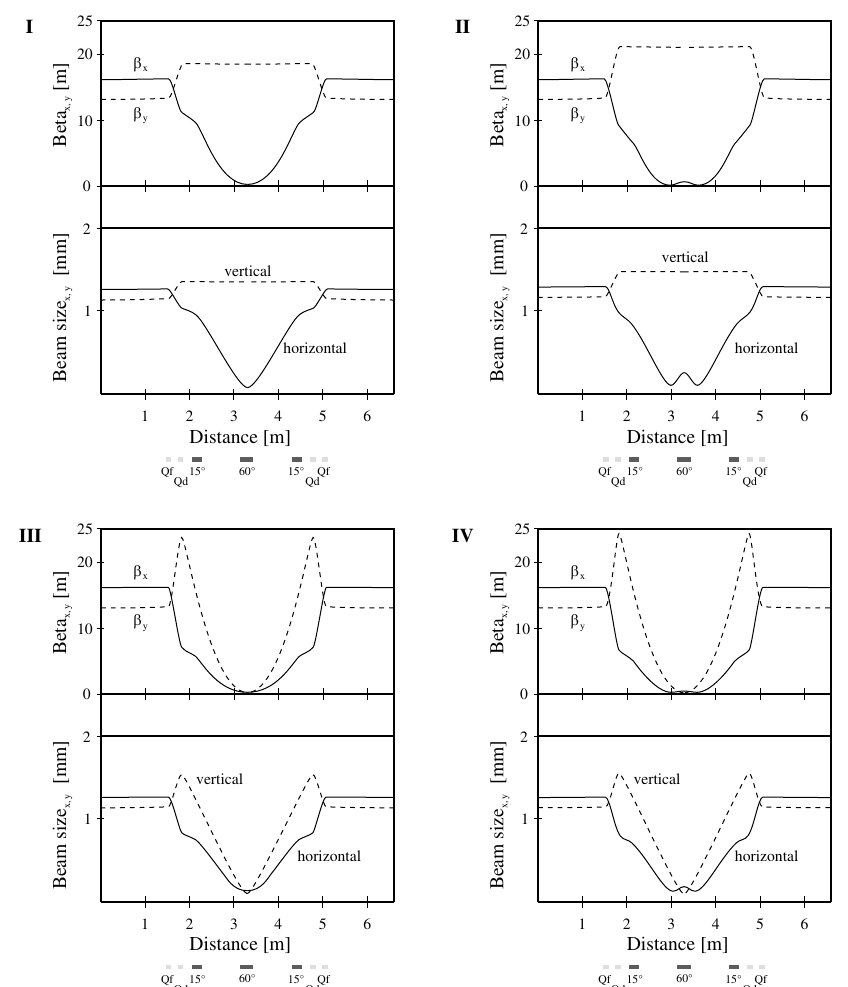
FIG. 3. Lattice functions and sizes in a quarter ring sections at working points I–IV. A detailed description is in the main